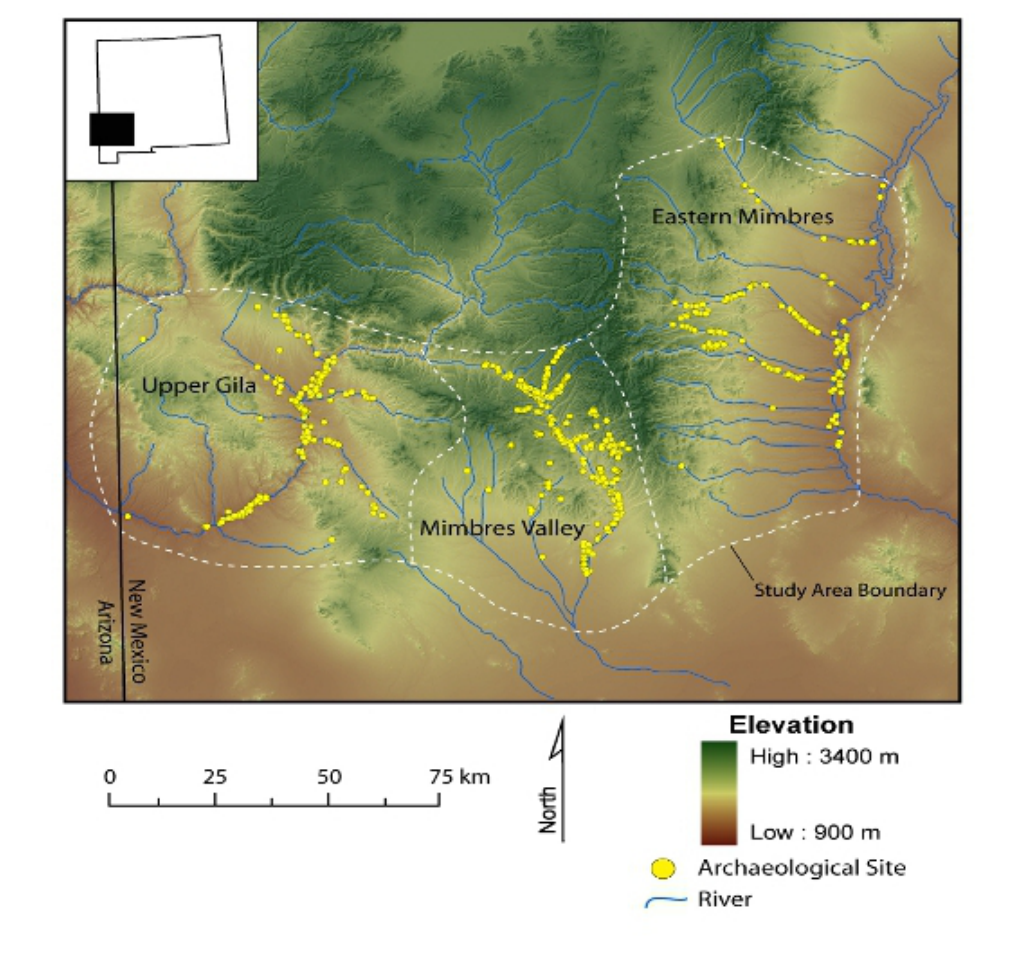
Fig. 2. Map of the Mimbres area, with landforms and